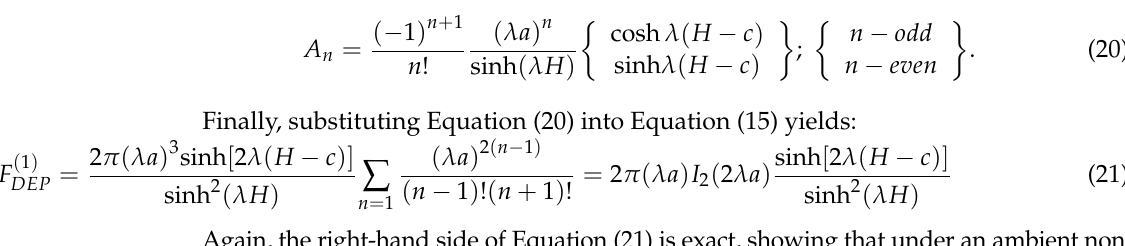
such that the lower electrolyte ( x 1 = − c ) is powered with a potential J 0 ( λ r ) , whereas the upper ( x 1 = H − c ) electrode is grounded. If the cylindrical wall of the pore is taken as insulating, then λ (the lowest eigenvalue) is determined by imposing J 1 ( λ b ) = 0, namely λ b = 3.8317, whereas if the wall is conducting J 0 ( λ b ) = 0, then λ b = 2.408. Expanding